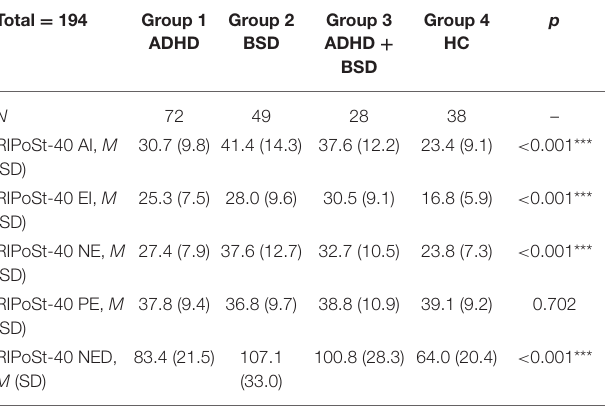
TABLE 2 | RIPoSt-40 subscales: comparisons among the PAT and HC